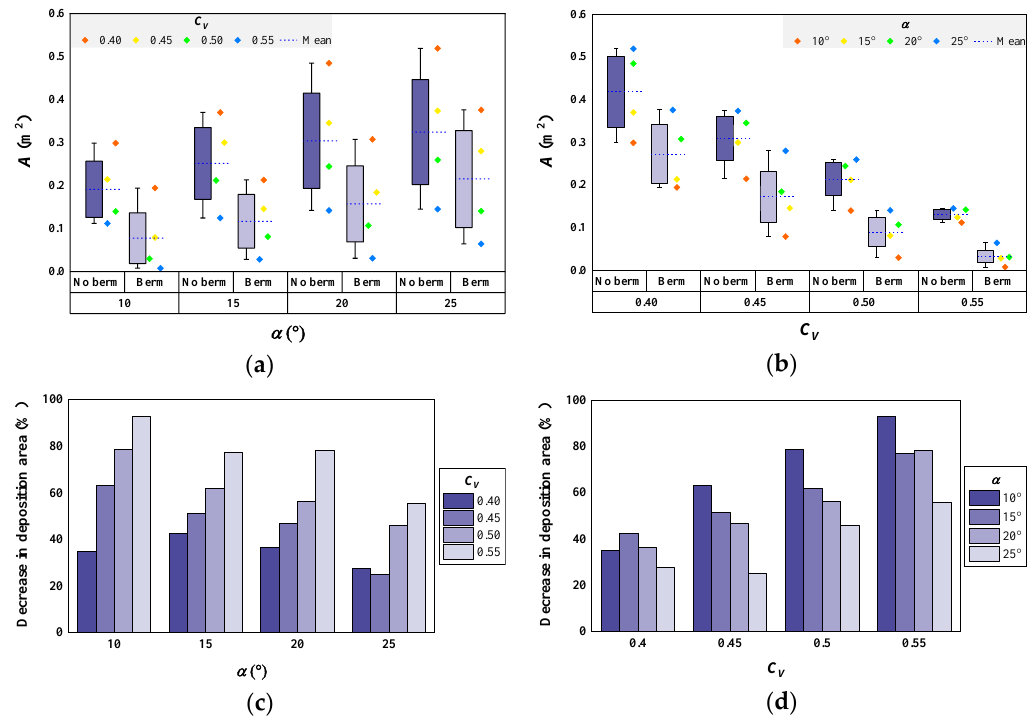
Figure 8. ( a ) Deposition area according to α (when C V = 0.40 – 0.55); ( b ) deposition area according to C V (when α = 10° – 25°); ( c ) percentage decrease in deposition area due to berm according to α (when C V = 0.40 – 0.55); ( d ) percentage decrease in deposition area due to berm according to C V (when α = 10° – 25°).